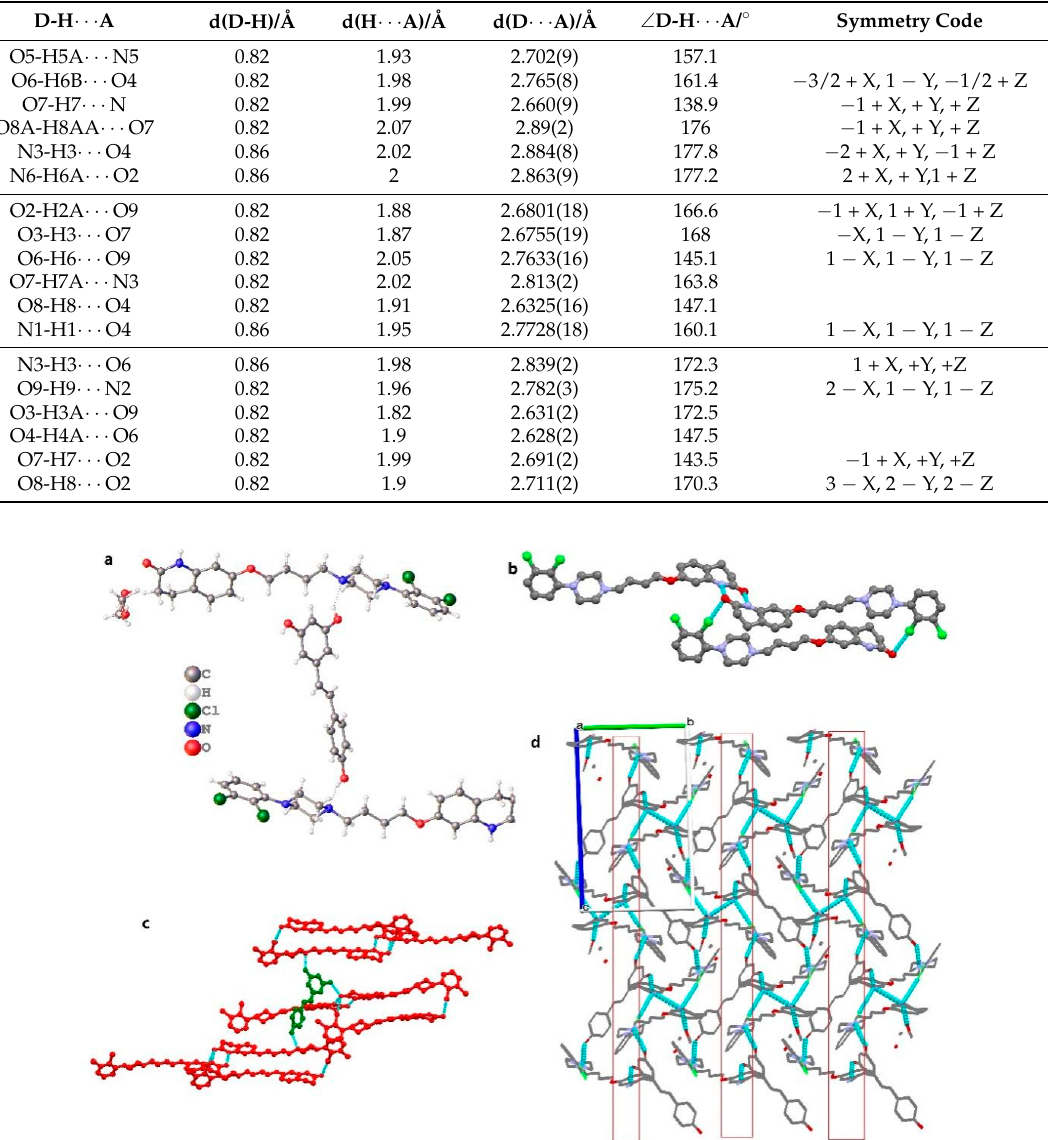
Table 2. Hydrogen bonding table for the cocrystals.